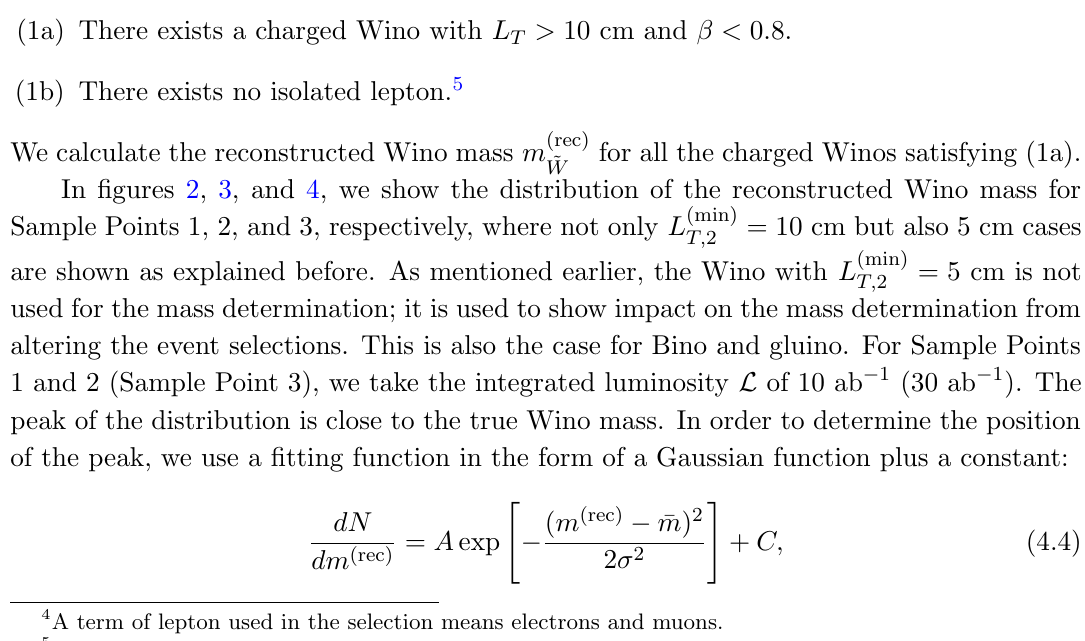
Figure 2 . Distribution of the reconstructed Wino mass for Sample Point 1, taking L (min) (left) and 5 cm (right) in a single experiment with the integrated luminosity of L = 10 ab (cid:0) 1